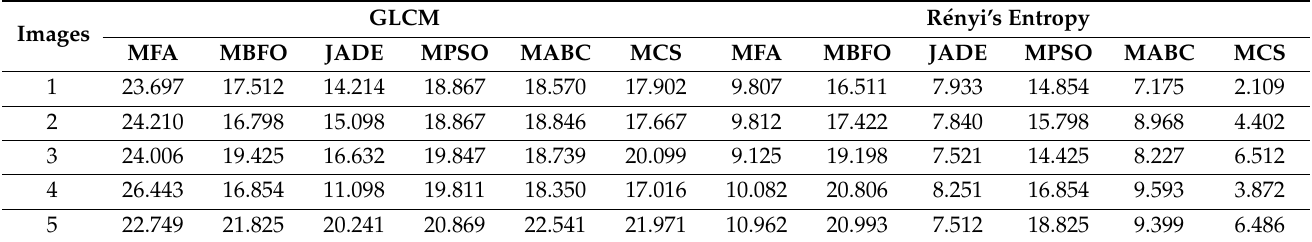
Table 7. CPU time using different optimization algorithms with GLCM and R é nyi’s entropy method.